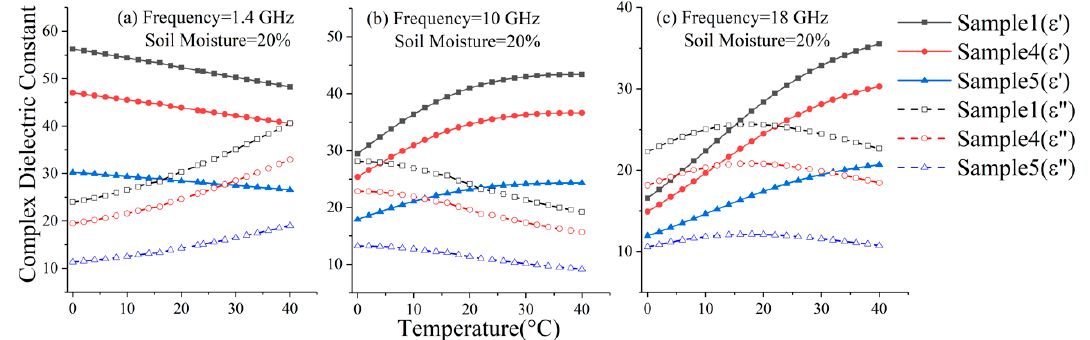
Figure 7. The temperature dependence of the complex dielectric constant for bound water of three types of soil at frequencies of ( a ) 1.4 GHz, ( b ) 10 GHz, and ( c ) 18 GHz; the curves were drawn based on the results from the Equation (13); physical properties of soils are shown in Table 1.